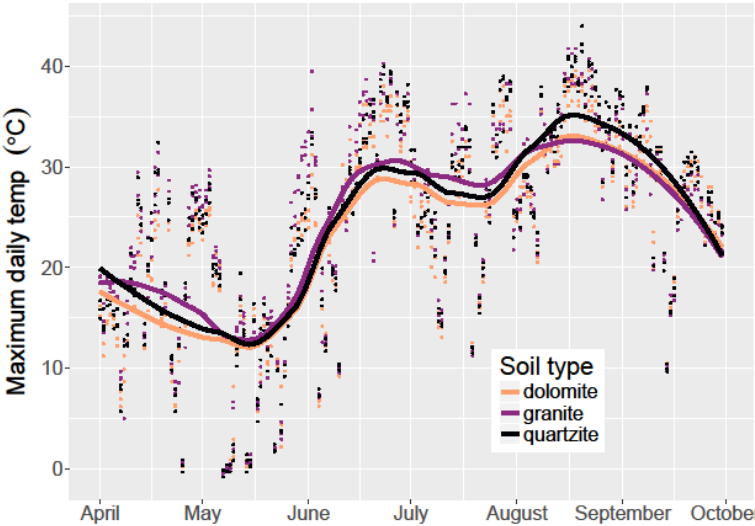
Figure 4. Maximum daily temperatures for the 2015 growing season. Lines were drawn using local regression (LOESS) smoothing with a span of regression (LOESS) smoothing with a span of 0.5.